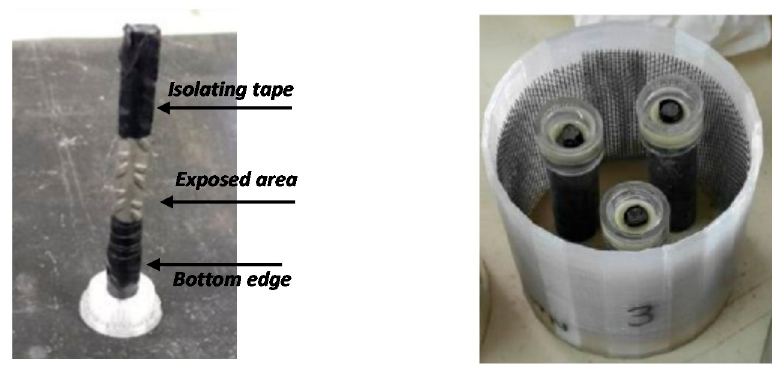
Figure 1. ( Left )—Rebar before embedding in mortar. ( Right )—Electrochemical cell with three reinforced mortar samples and the stainless-steel mesh used as a counter-electrode for the electrochemical tests.